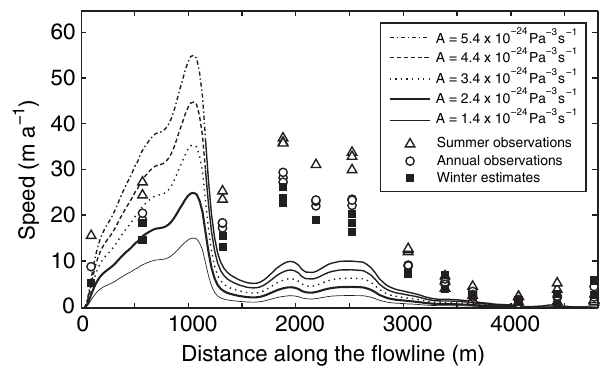
Fig. 4. Measured and modelled glacier surface speed along the flowline. Estimates of winter flow speed (squares) have been made from measured annual (circles) and summer (triangles) flow speeds, assuming the summer speeds are representative of a four-month pe- riod. Modelled profiles represent different values of the flow-law coefficient A in simulations with no basal flow. Error bars on the measurements are omitted in the interest of